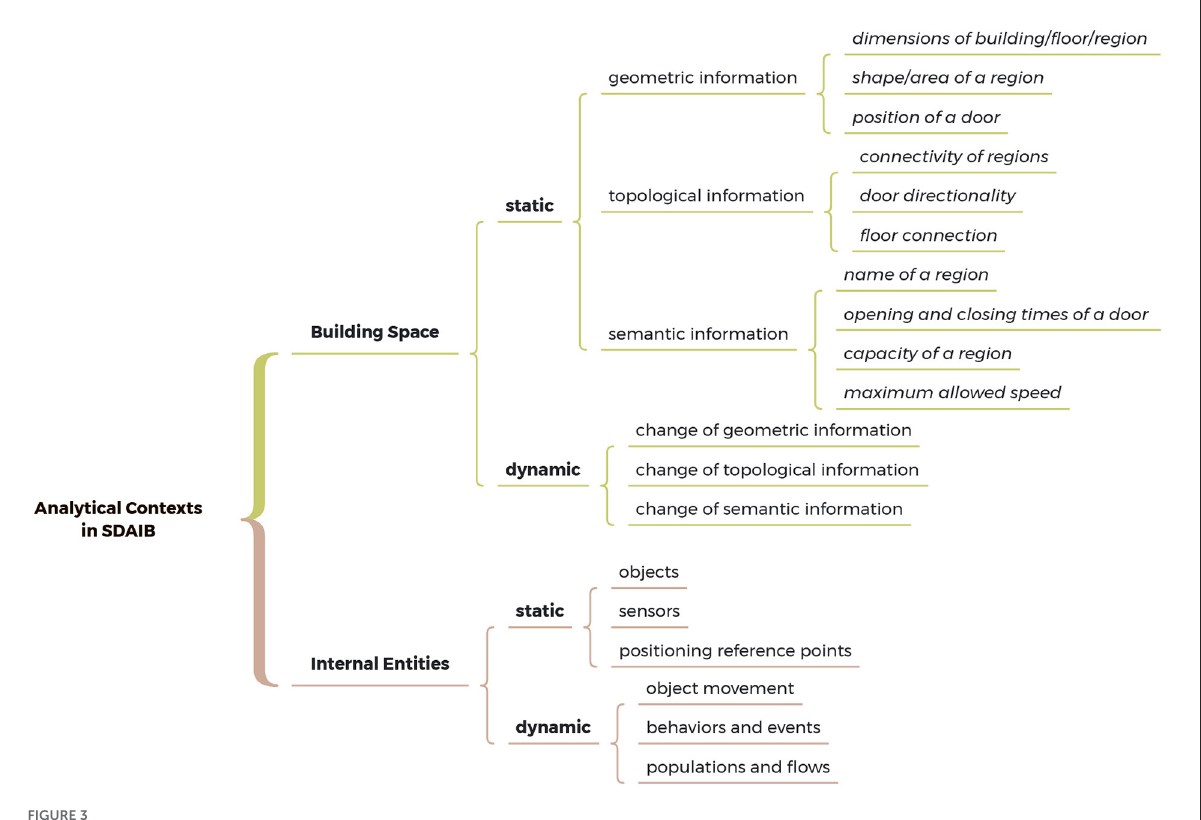
FIGURE3 A non-exhaustive taxonomy of the analytical contexts in